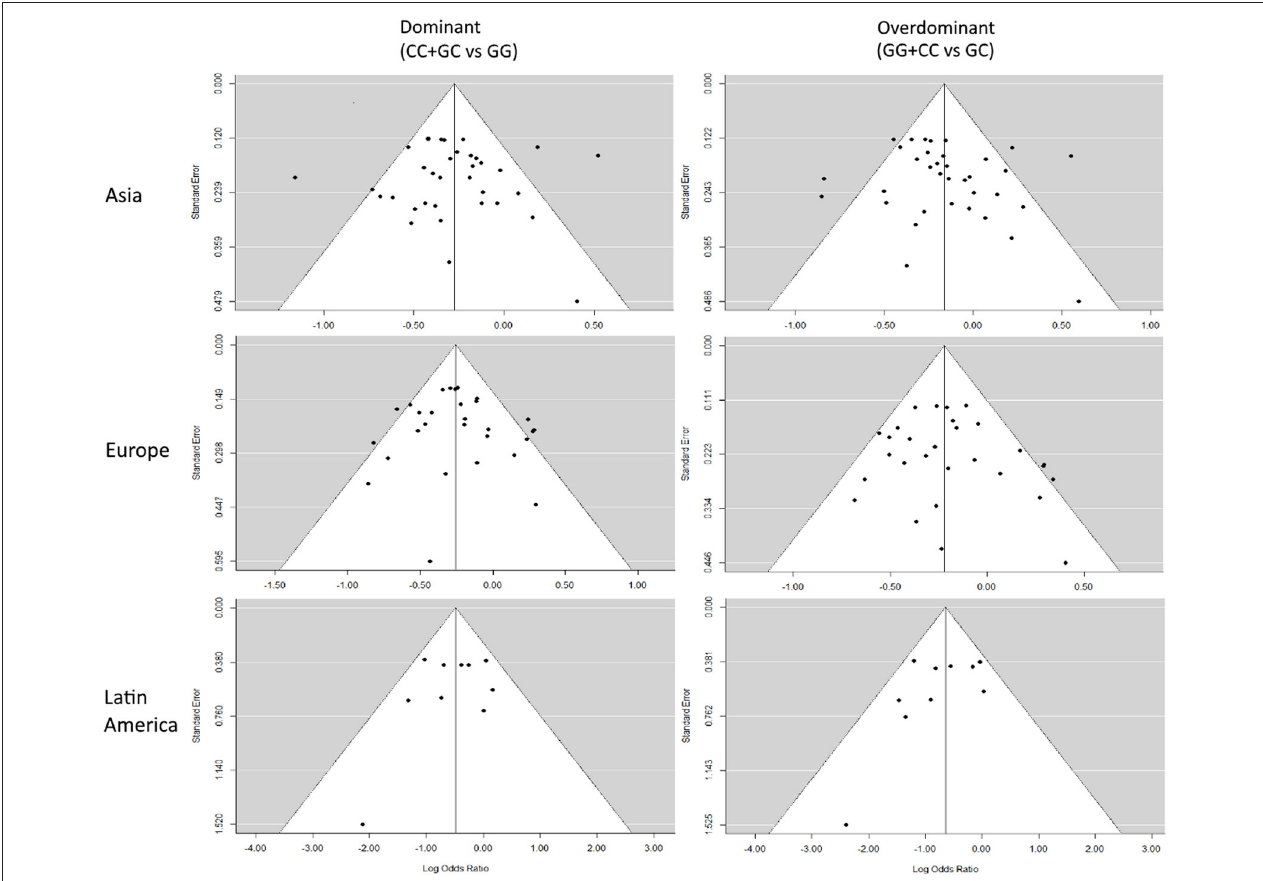
FIGURE 4 | Representative Funnel plots . Funnel plots of Asian, European, and Latin American subdivisions on the dominant and overdominant models. The vertical solid line represents the summary effect estimate, and the 95% CI zone is shown in white.